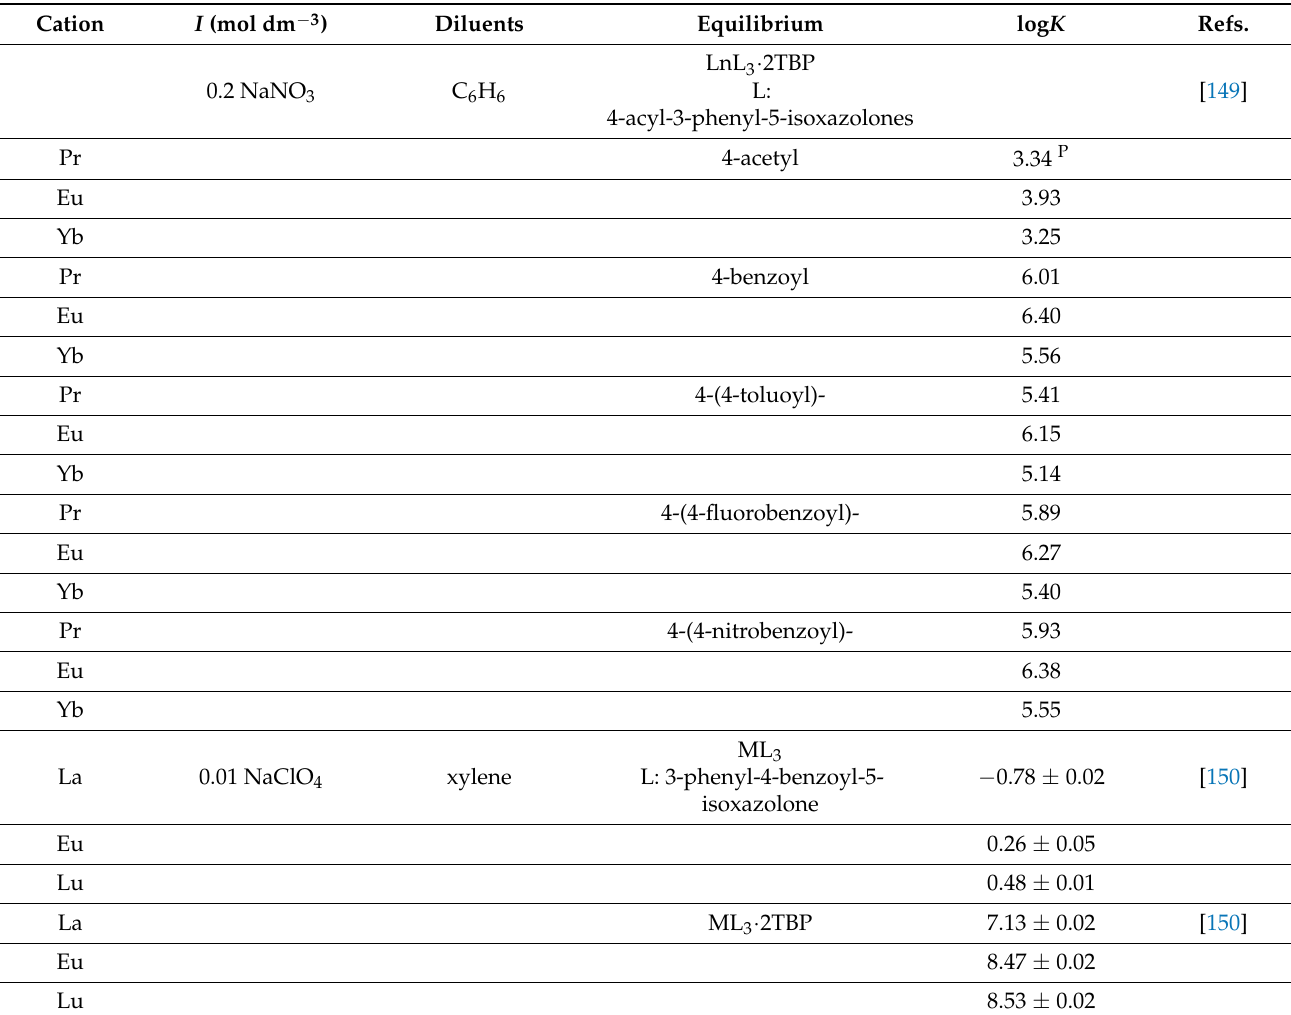
Figure 16. Variation of the J quantum number for the trivalent lanthanoids with the number of f-electrons in the series. Table 7. Recommended data (noted as “P”) for the synergistic system of 4-acyl-5-isoxazolone and organophosphorus